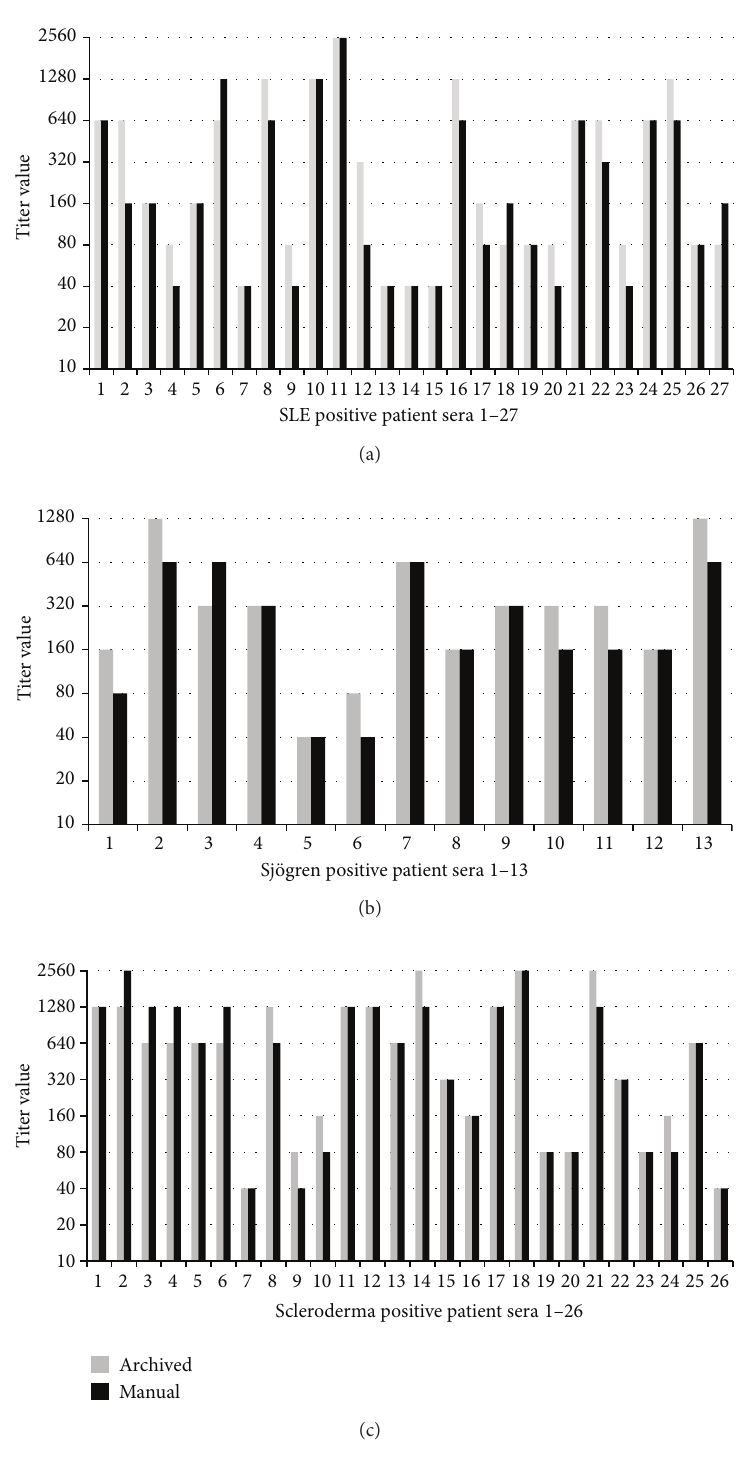
Figure 1: Antinuclear antibodies in different patient cohorts. (a) 27 positive systemic lupus erythematosus (SLE) patient sera titered at 1: 40 through 1:2560. (b) Thirteen positive Sj¨ogren’s syndrome (SjS) patient sera titered at 1: 40 through 1 :1280. (c) 26 positive scleroderma patient sera titered at 1: 40 through 1: 2560. The gray bar represents the end point titer read on the NOVA View archived image. The black bar represents the titer read on a traditional manual microscope. All titers were read by the same